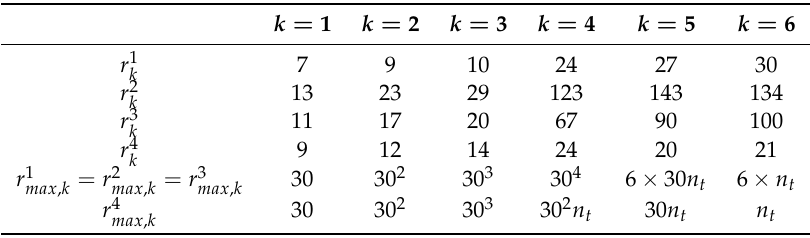
Table 1. TT-ranks of the outputs of interest and theoretical maximum ranks.